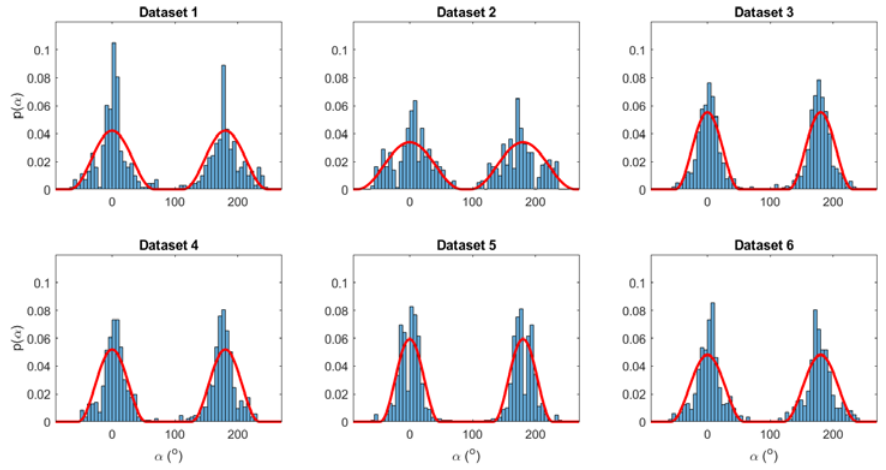
Figure 8. Elevation angle histograms and estimated distribution functions.